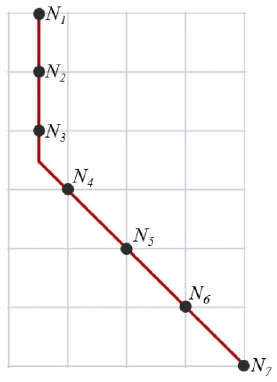
Figure 1. Ship route decomposition diagram.